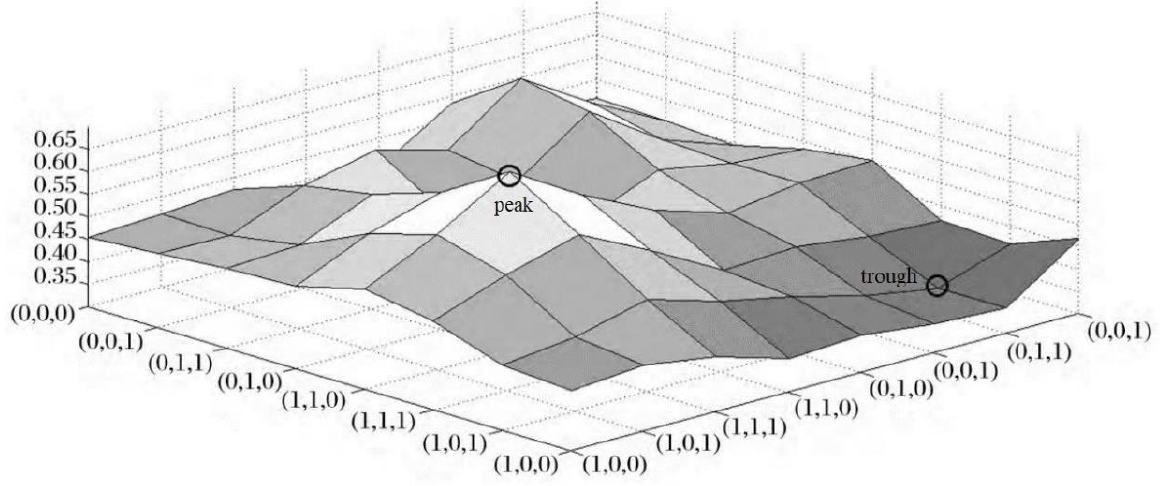
Figure 3. Fitness landscape map.